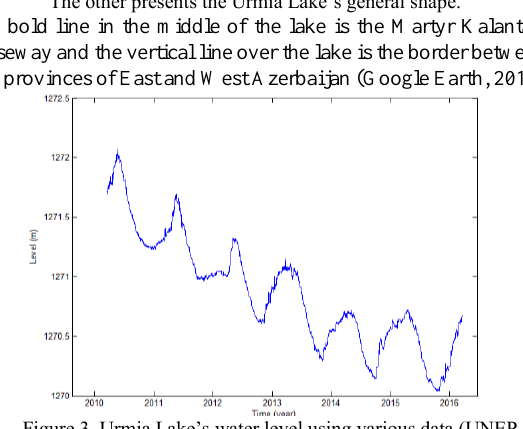
Figure 1. Lake Urmia drainage basin in the north west of Iran (Abbaspour et al. 2012)